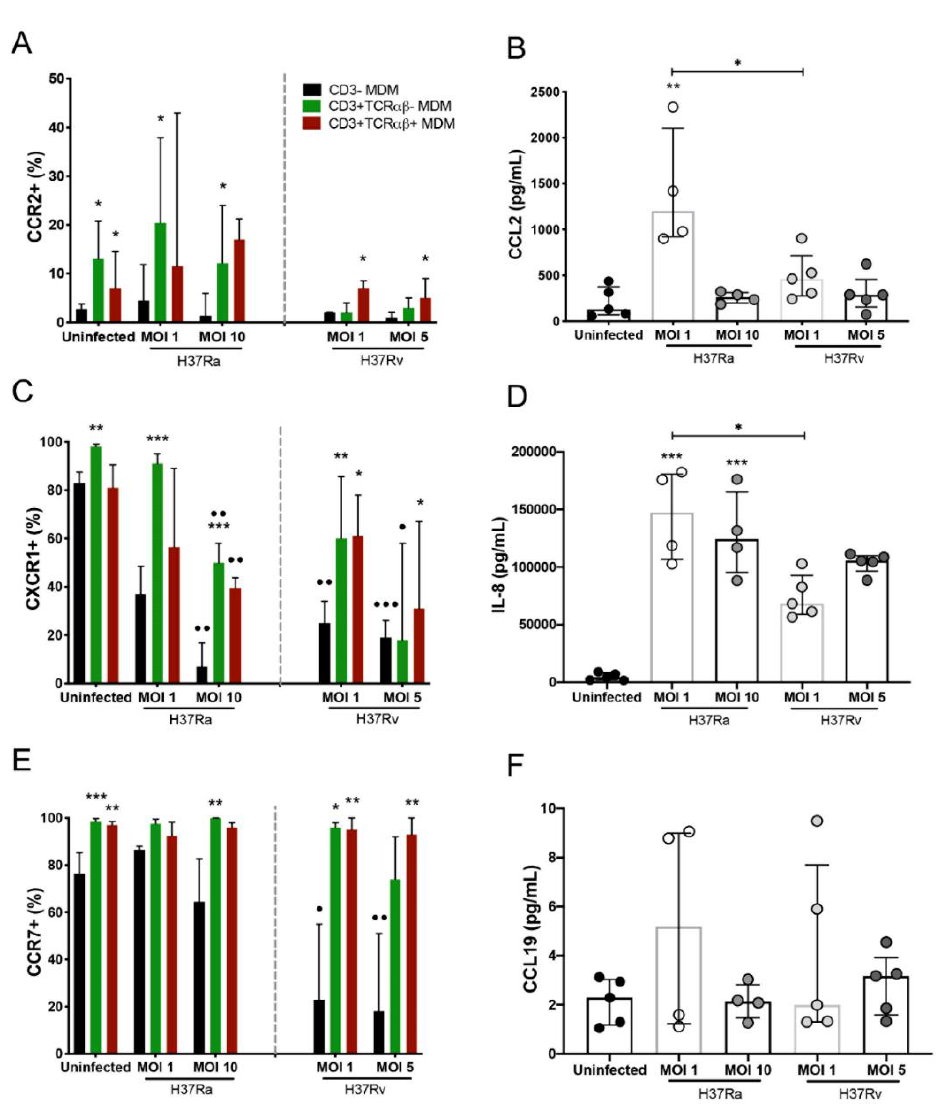
Figure 5. Chemokine receptors and their ligands implicated in the host inflammatory response are differentially expressed in Mycobacterium tuberculosis (Mtb) H37Ra- or H37Rv-infected CD3 − and CD3 + monocyte-derived macrophages (MDMs). After 7 days in culture, 2 × 10 6 MDMs (per condition) were infected, and at 24 h post-infection, MDMs were recovered for flow cytometric analysis, and the supernatants were recovered for ELISA. ( A ) CCR2, ( C ) CXCR1, and ( E ) CCR7 chemokine receptors were quantified by flow cytometry. Soluble levels of the ( B ) CCL2, ( D ) IL-8, and ( F ) CCL19 chemokines were assessed in culture supernatants by ELISA. Bar graphs in A, C, and E show median values and interquartile ranges (IQRs, 10–90) from four independent experiments; scatter plots with bar in B, D, and F show median values and IQRs from five independent experiments. Kruskal–Wallis tests followed by Dunn’s post-tests with bar were performed to compare macrophage subpopulations under the same MOI conditions versus the CD3 − MDM subpopulation, * p < 0.05, ** p < 0.01, *** p < 0.001, and to compare the same macrophage subpopulation in a different condition of culture, • p < 0.05, •• p < 0.01, ••• p < 0.001. In addition, for the analysis of soluble chemokine levels, the Kruskal–Wallis test followed by Dunn’s post-test was performed to compare infected versus uninfected MDMs or between groups (when indicated), * p < 0.05, ** p < 0.01, *** p <